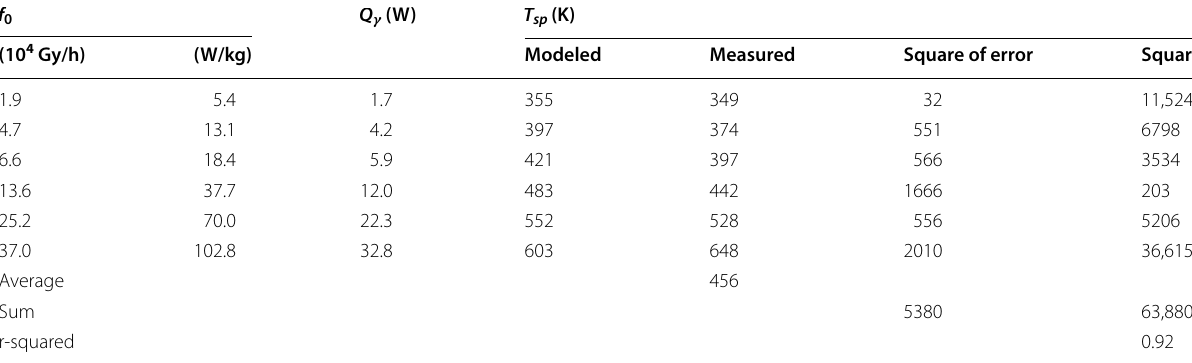
Table 1 Observed and modeled T sp with associated sum of square of errors, sum of squares, and